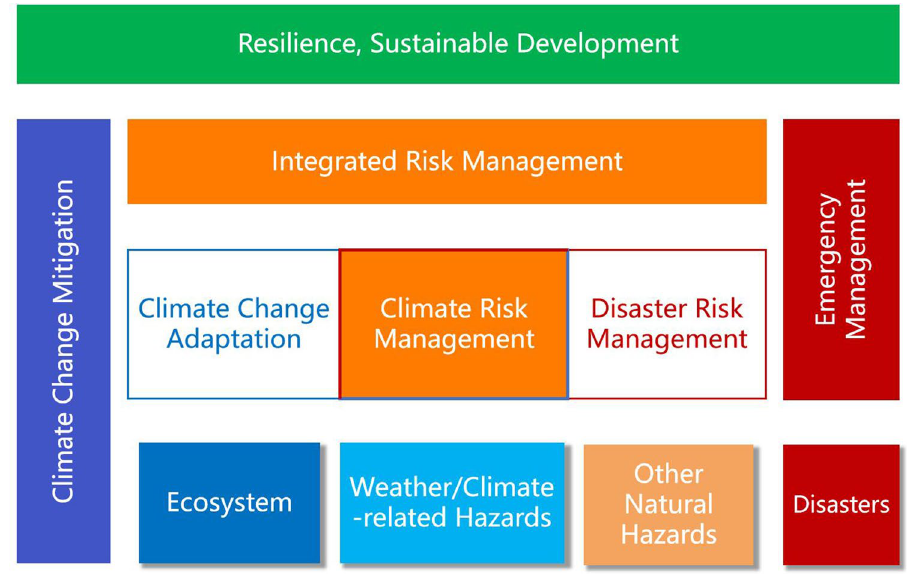
Fig. 5 A framework for address- ing disaster and climate change risks in the context of resilient, sustainable